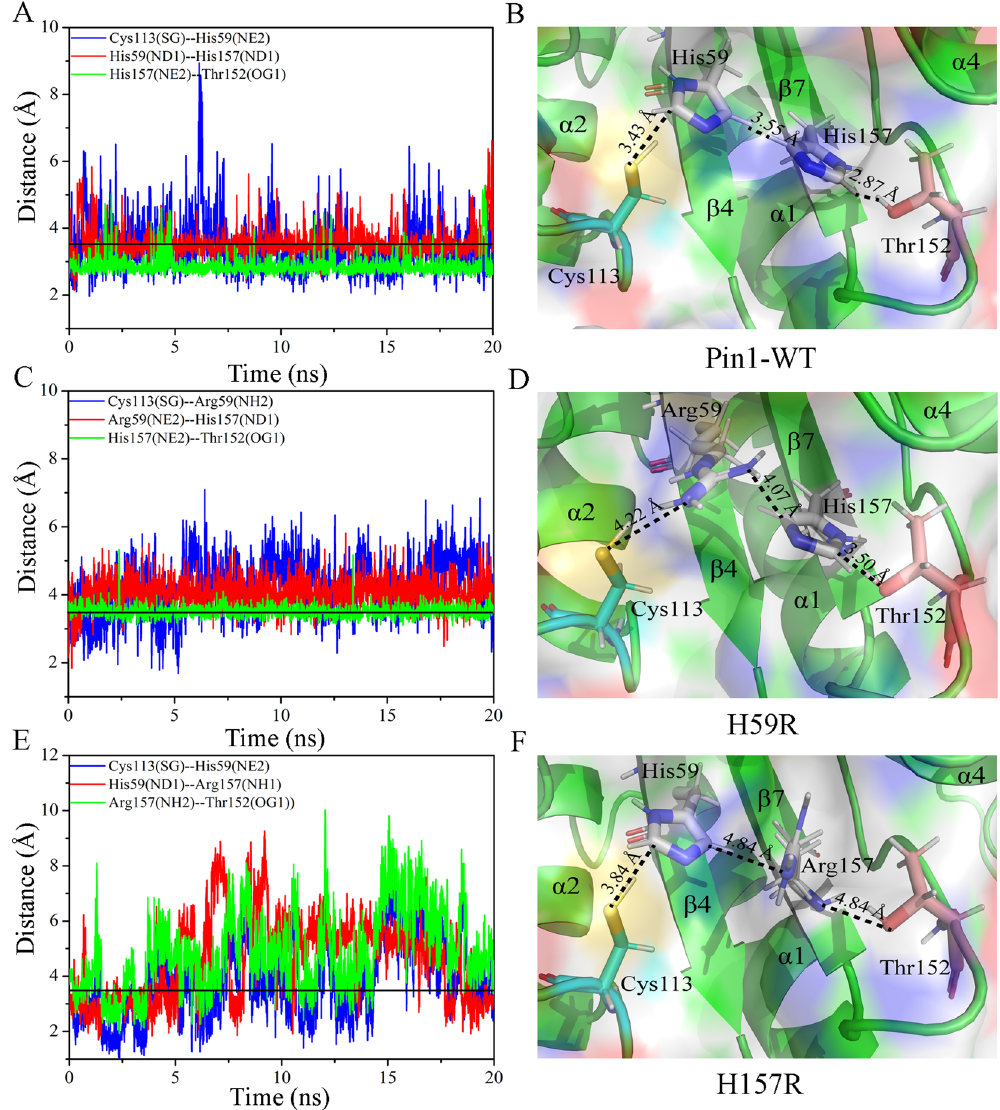
Figure 9. The distance between dual-histidine motif in Pin1-WT, H59R and H157R as a function of 20 ns MD simulation. ( A , B ) Represent the distance and model of the dual-histidine motif in Pin1-WT, respectively. ( C , D ) Represent the distance and model of the dual-histidine motif in H59R, respectively. ( E , F ) Represent the distance and model of the dual-histidine motif in H157R, respectively. The black line represents the cut-off distance of hydrogen bond as 3.5